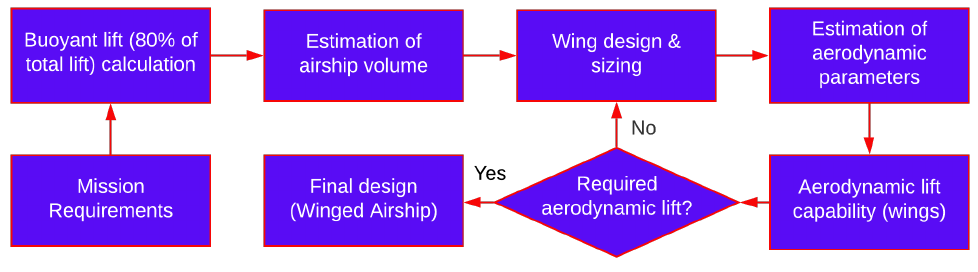
Figure 7. Sizing of envelope and wing for the given buoyant ratio